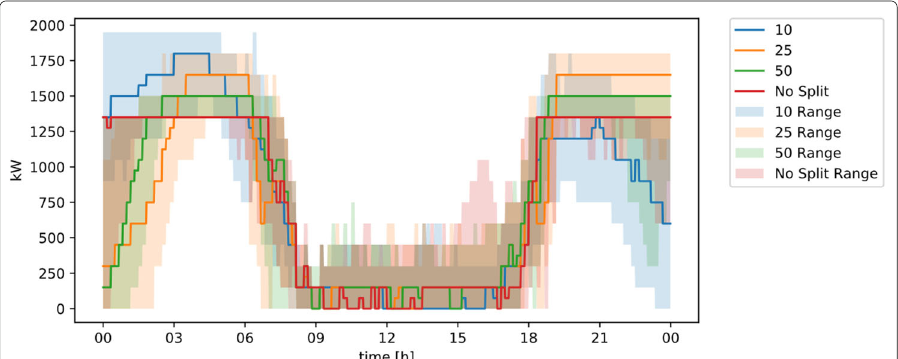
Fig. 6 Power Profiles at Different Sub-fleet Sizes. Solid line — median; fill —